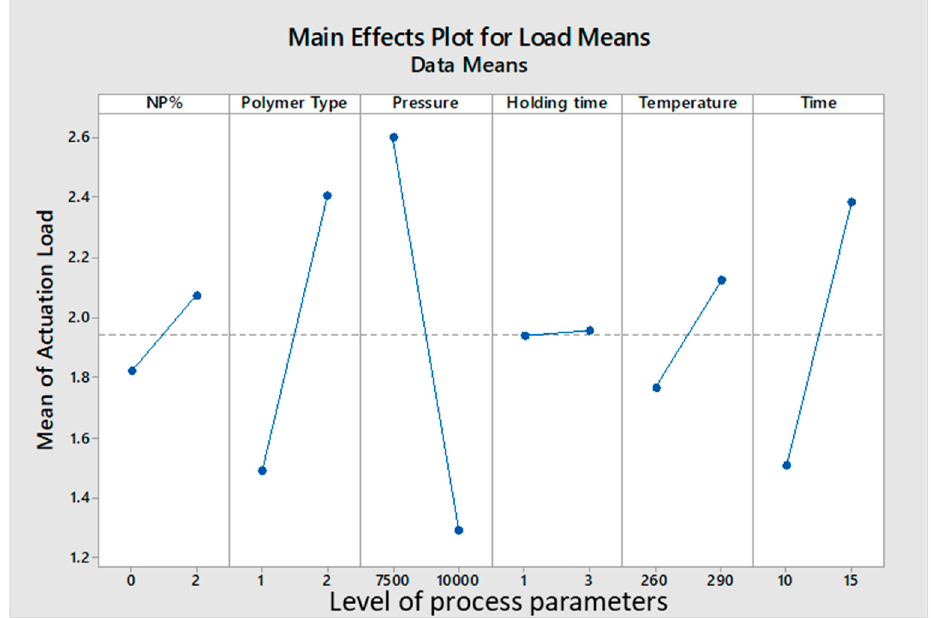
Figure 8. Effect of parameters on the actuation load.